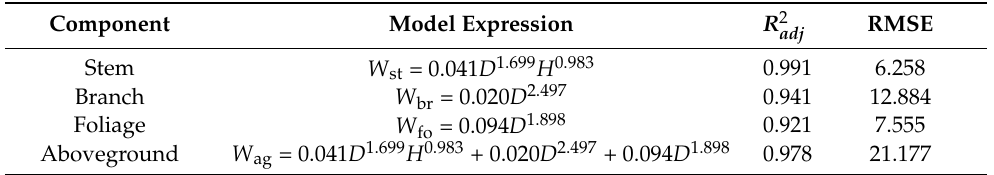
Table 3. Additive biomass models developed by simultaneously fitted (WNSUR) procedure based on the selected equations for each